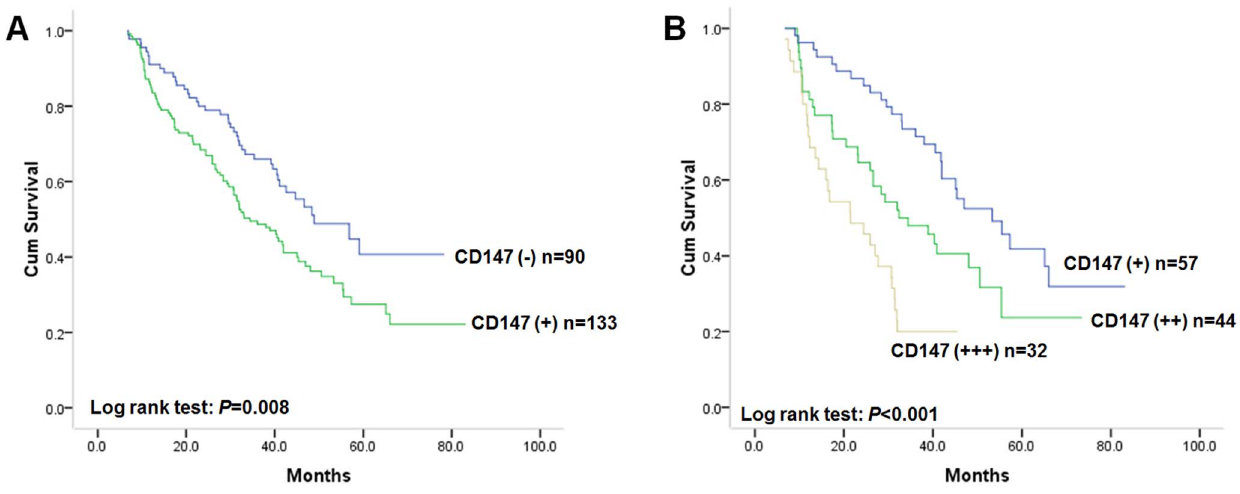
Figure 2. A Kaplan-Meier postoperative survival analysis on disease-free survival of primary gastric patients (n=223) with positive CD147 staining (n=133) and negative CD147 staining (n=90). The disease-free survival for patients in negative CD147 staining group was significantly better than that for patients in positive staining group (log rank test: P =0.008); B Kaplan-Meier postoperative survival analysis on disease-free survival of primary gastric patients with positive CD147 staining (n=133). The disease-free survival rate was decreased from weak positive ( + , n=57), moderate positive